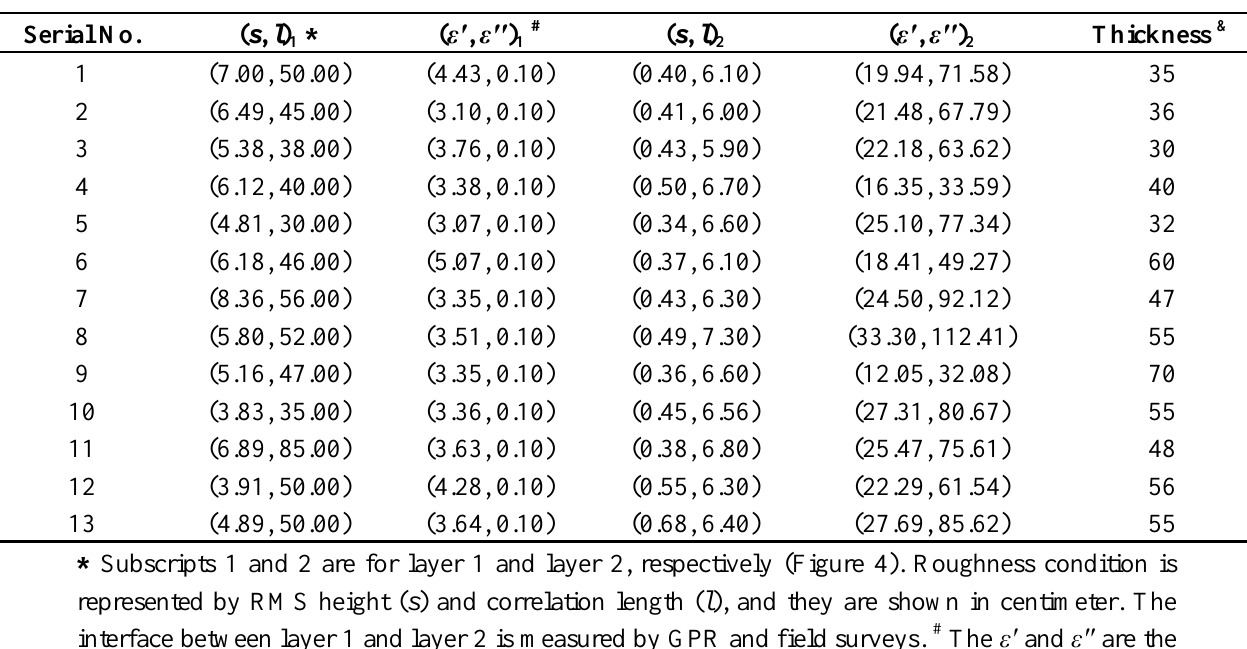
Table 1. Physical-chemical parameters used in